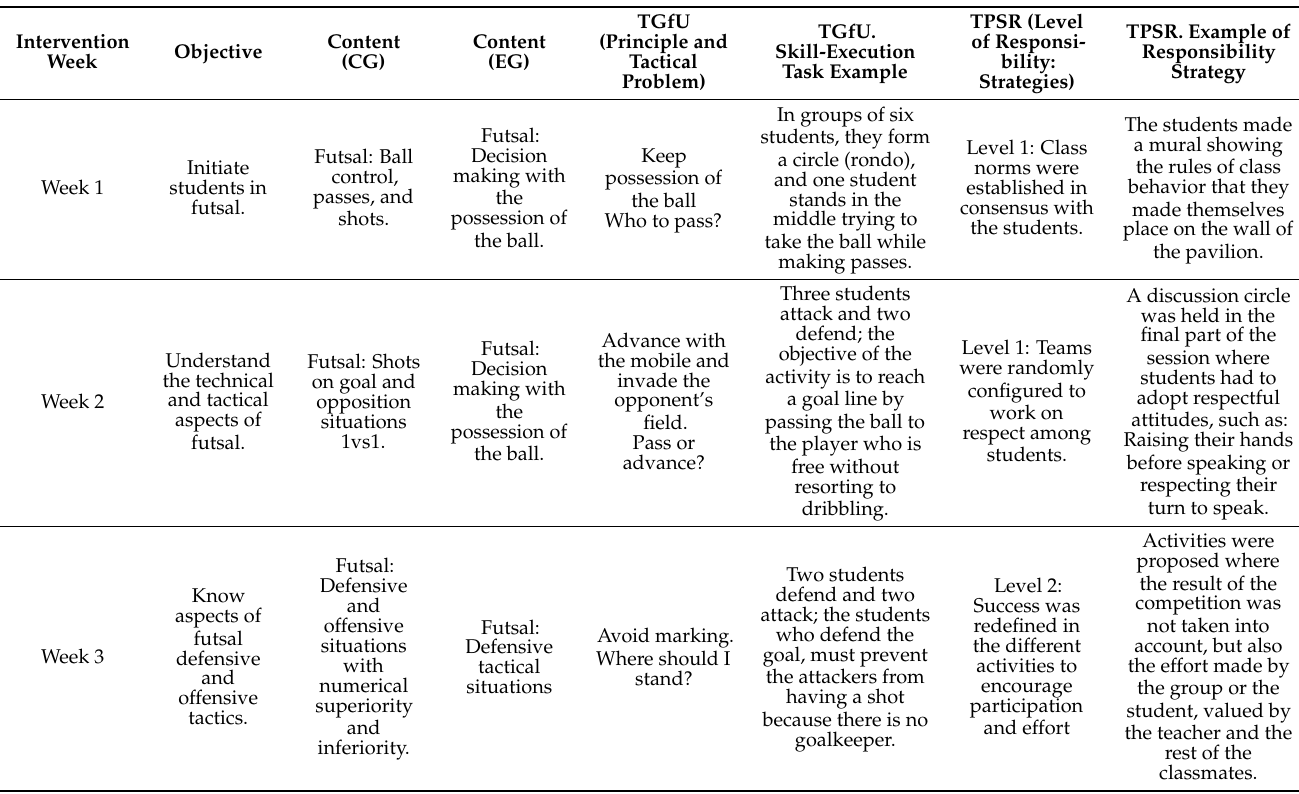
Table 1. Weeks, objectives, contents, principle, tactical problems, and skill-execution tasks, levels of responsibility, strategies, and examples of tasks during the